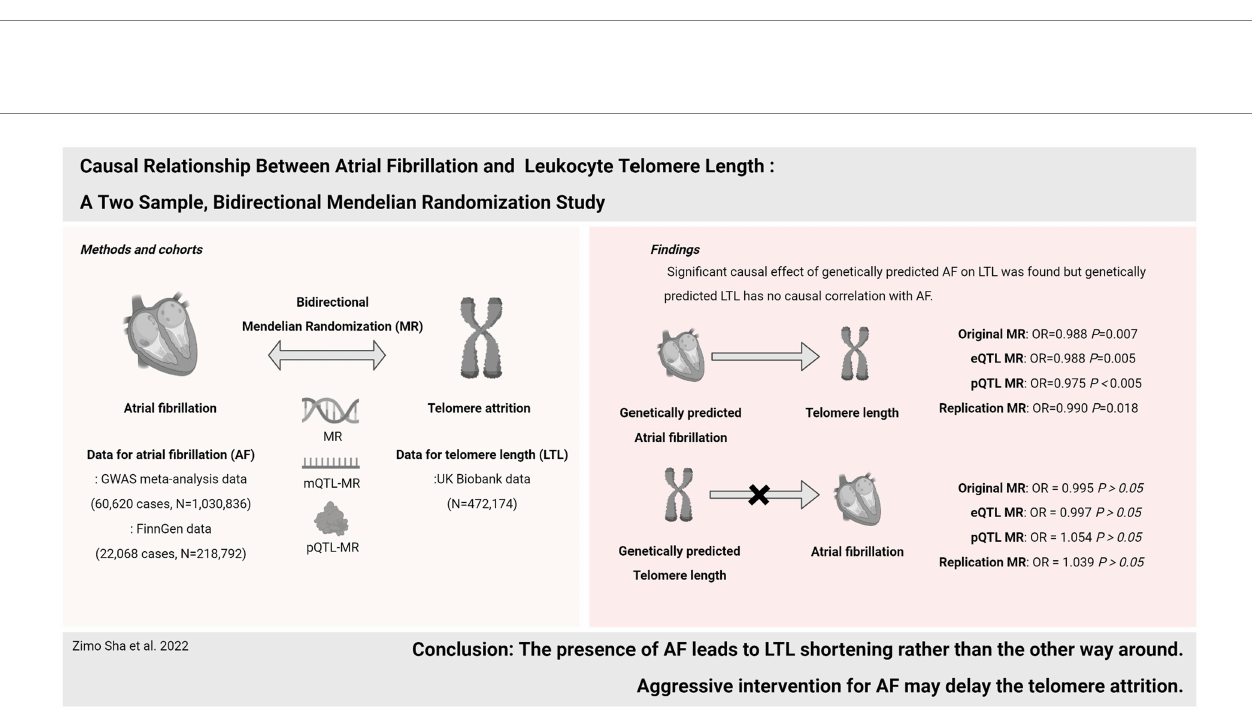
FIGURE 4 Causal relationship between atrial fibrillation and leukocyte telomere